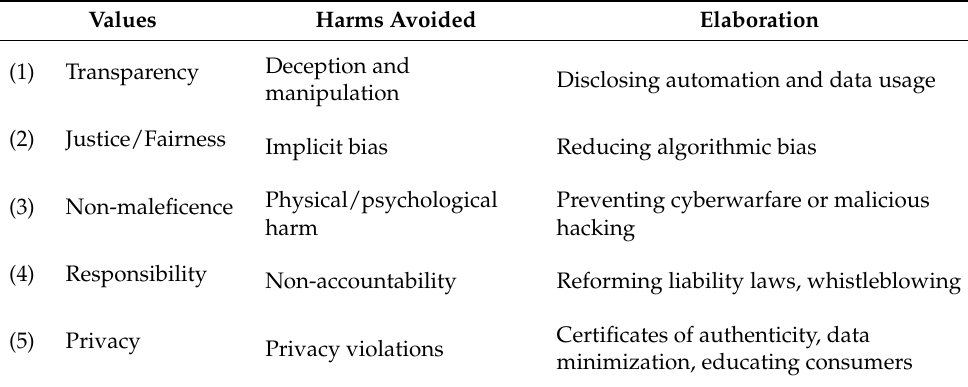
Table 1. Precautionary Values in International Ethics